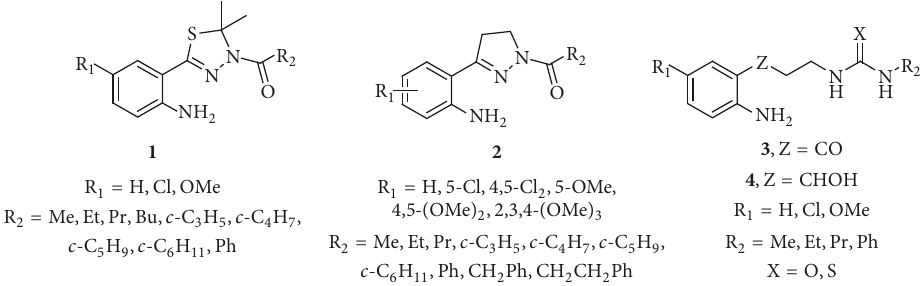
Figure 1: Structure of thiadiazolines 1 , pyrazolines 2 , and N , N 󸀠 -disubstituted urea and thiourea derivatives 3 - 4 with NOS inhibitory activity.